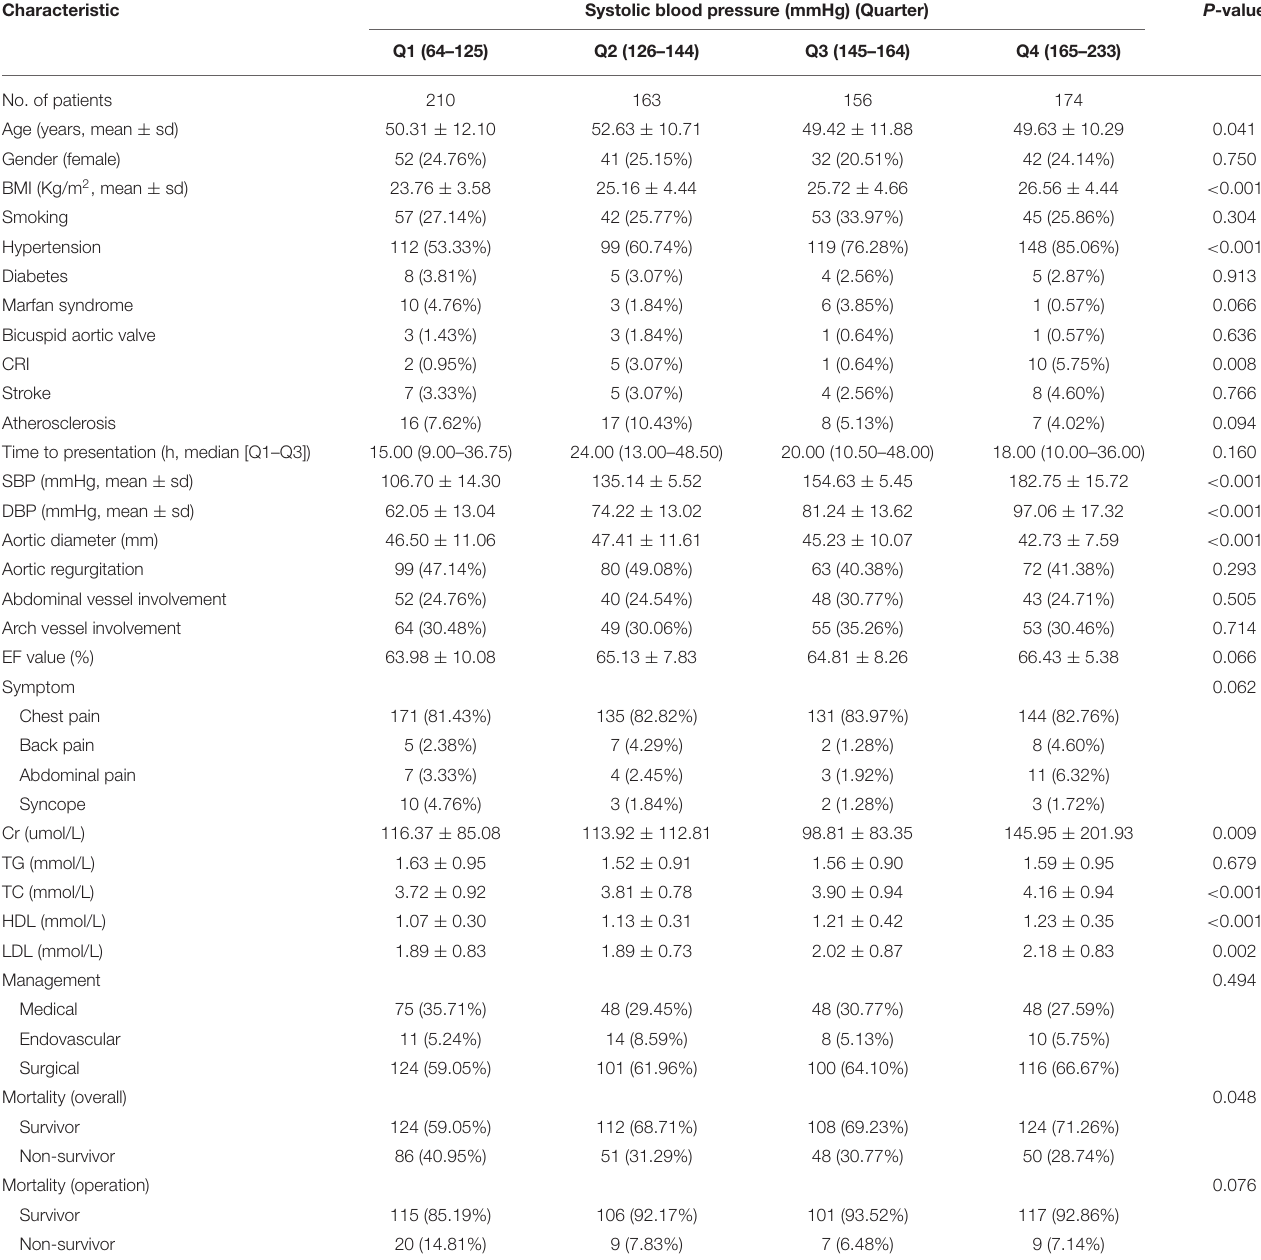
TABLE 1 | Basline characteristics of the patients ( N =